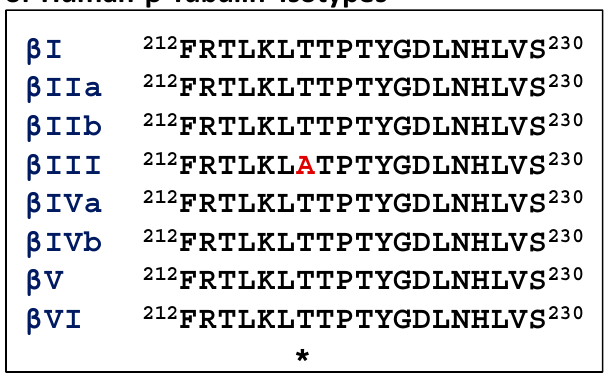
Figure 3. Sequence alignment of the leucine cluster of human β -tubulin isotypes. The asterisk denotes an altered residue (in red).